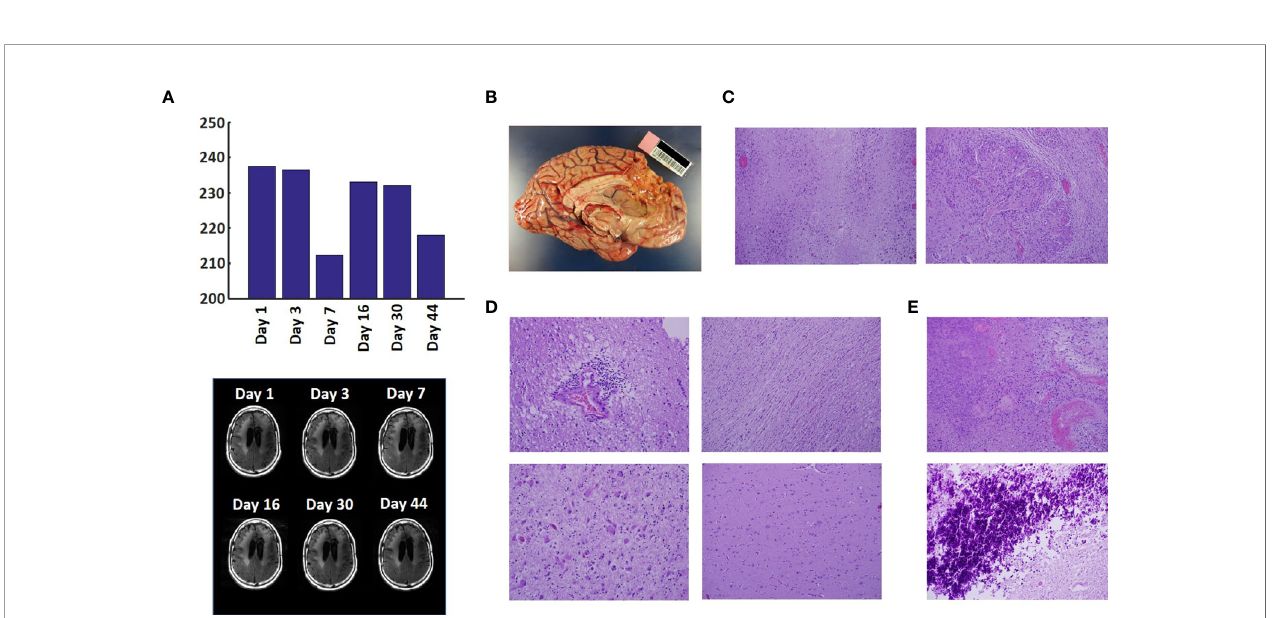
FIGURE 3 | Variation in Enhanced Intensity Volumes in T2-FLAIR MRI Scans and Autopsy Findings. (A) Top – Bar plots of the volumes of T2-FLAIR intensity enhancement in the whole brain at different time points. Overall, there was up to 11% decrease in T2 FLAIR volume over the course of treatment. Bottom – Representative T2-FLAIR images are shown. (B) Left hemisphere of the brain, examined grossly, showing no tumor mass. (C) Photomicrographs of the left cortex showing bland necrosis, residual tumor, and microvascular proliferation with thick-walled vessels. (D) Top left – Microscopic fi eld of the left cingulate cortex showing a focus of rare fi ed, perivascular in fl ammation. Bottom left – Cortical fi eld showing rare fi ed parenchyma and residual tumor cells, enlarged with treatment-type effect that can be seen in GBM. Top right – Micrographic fi eld of the corpus callosum showing thinned, rare fi ed white matter tract. Bottom right – Field showing relatively uninvolved contralateral (right) cortex. (E) Top – Micrographic fi eld in the left cortex showing infarct-like necrosis (left), tumor (right), and fi brin thrombus (lower right). Bottom – Left cortical fi eld showing necrotic tissue with dystrophic calci fi cation.